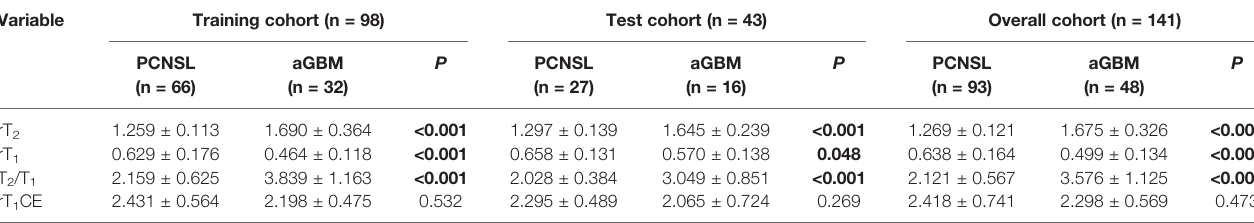
TABLE 4 | Quantitative MR signal intensity ratio comparisons between PCNSL and aGBM.